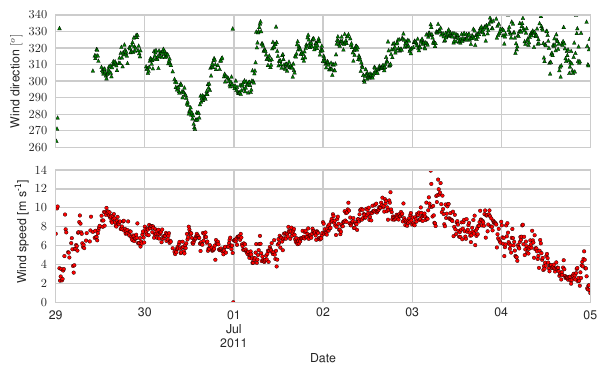
Figure 6. Inflow conditions: measured wind speed and wind direc- tion at FINO1 at a height of 91.5 m LAT during a selected period from 29 June 2011 at 00:00UTC until 5 July 2011 at